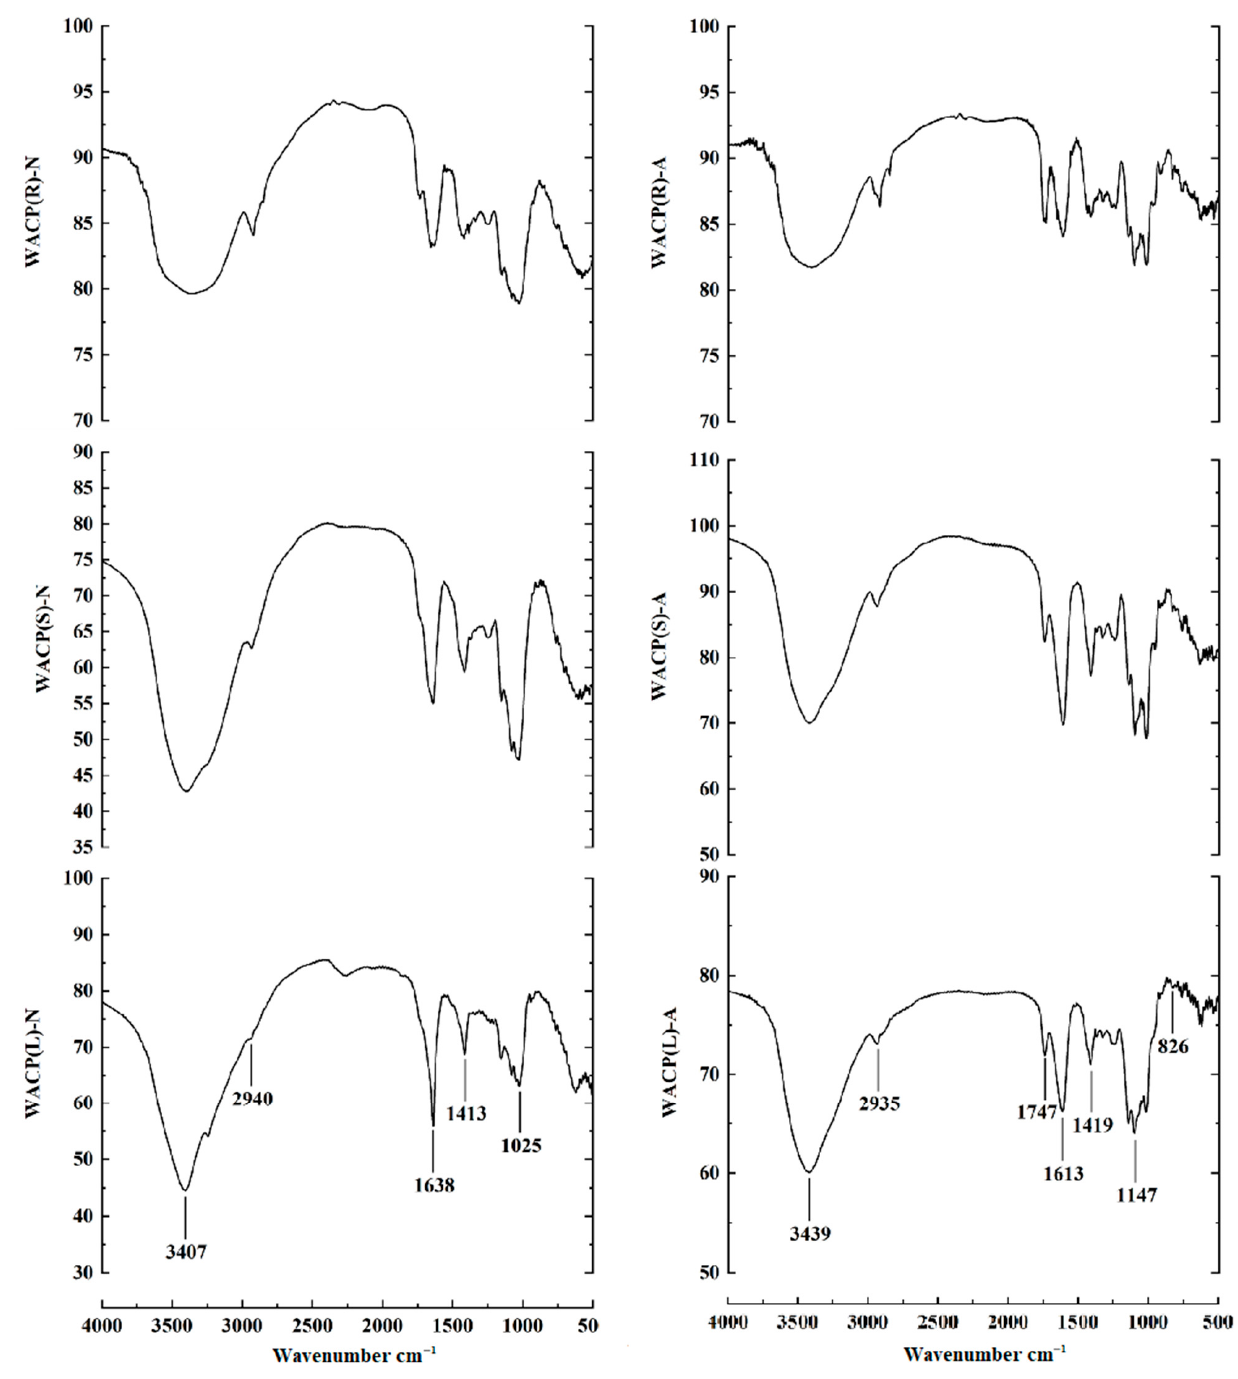
Figure 1. FTIR spectra of the polysaccharide fractions. (WACP(R)-N, WACP(S)-N, WACP(L)-N, WACP(R)-A, WACP(S)-A and WACP(L)-A). 2.4. In Vitro Antioxidant Activity Assays of the Polysaccharides from A. continentalis